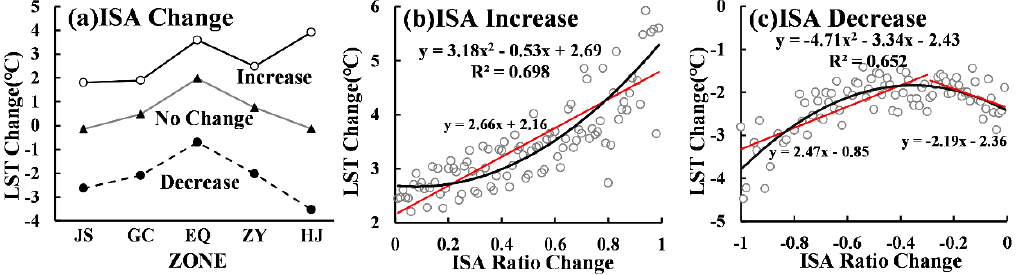
Figure 11. The impacts of ISA changes on LST changes.